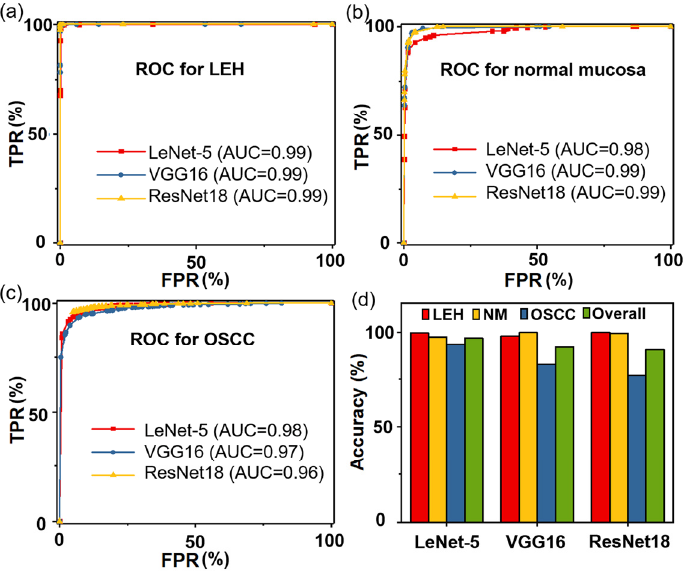
Figure 3. The classification evaluation of three kinds of CNNs. ( a – c ) are the ROCs and AUCs of distinguishing three types of tissues using these three CNNs, respectively. ( d ) is the classification accuracies of three types of tissues with three types of CNNs. TPR: true positive rate, FPR: false positive rate.